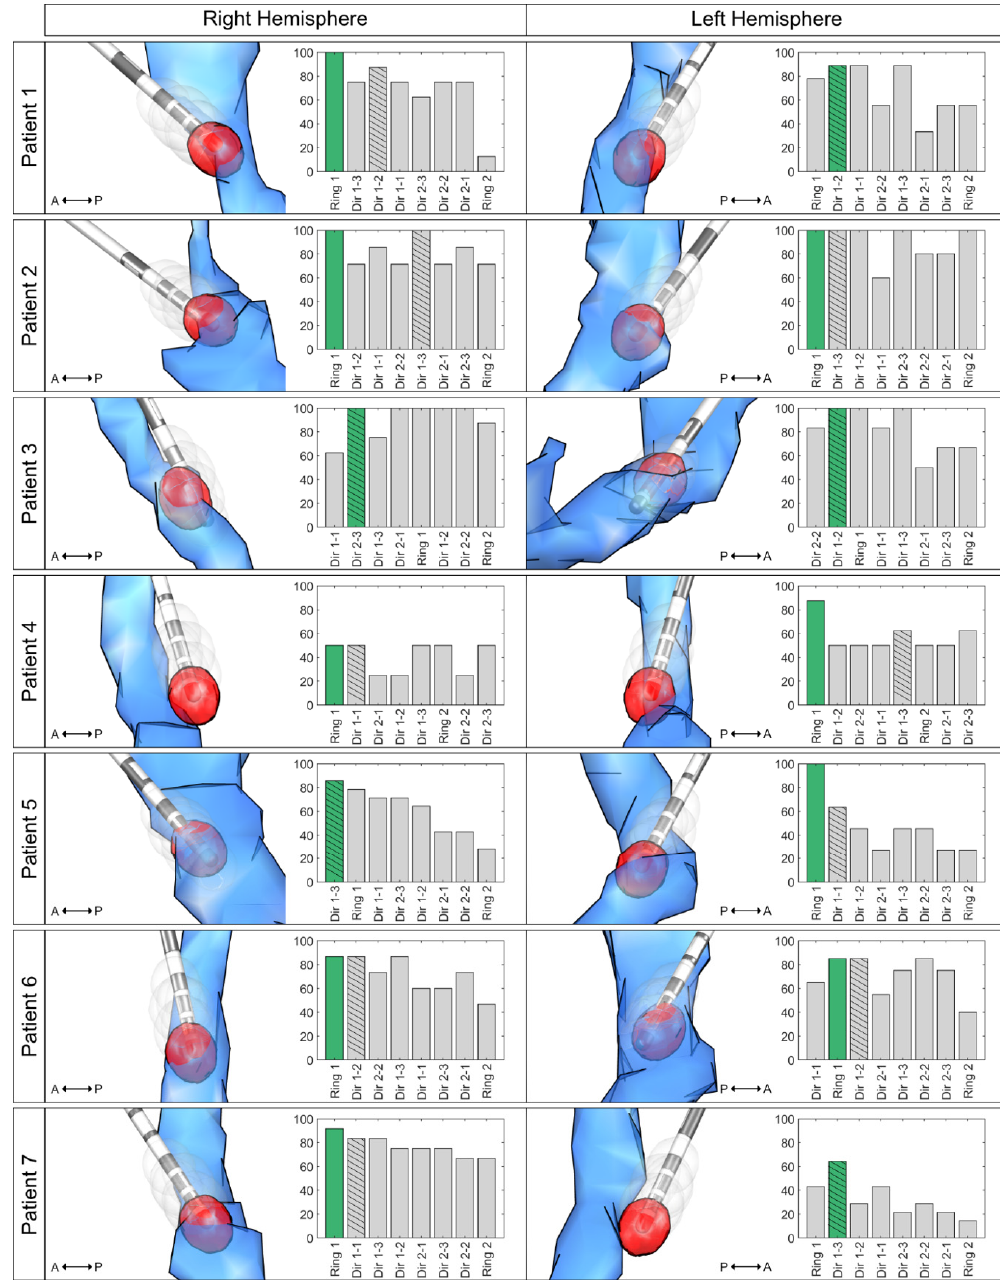
Figure 1. Contact Ranking. Bar plots illustrate the ranking of the overlap, with the individual dentatorubrothalamic tract (DRTT) per contact on the x axis (highest overlap to lowest overlap) and the improvement in tremor control in % on the y axis. The most e ff ective contact is marked in green (with the highest overlap in cases where more than one contact had the best improvement), and the most e ff ective directional contact bar is hatched. The respective left column illustrates the relation between the generated volumes of tissue activated (VTAs, gray) and the DRTT (blue) and the respective lead in the medial view. The VTA with the highest DRTT overlap is highlighted in red. For illustration, only the 10% highest values of the track probability map are shown. Abbreviations: A = anterior; DRTT = dentatorubrothalamic tract; P = posterior; VTA = volume of tissue activated; Dir 1 = ventral directional level; Dir 2 = dorsal directional